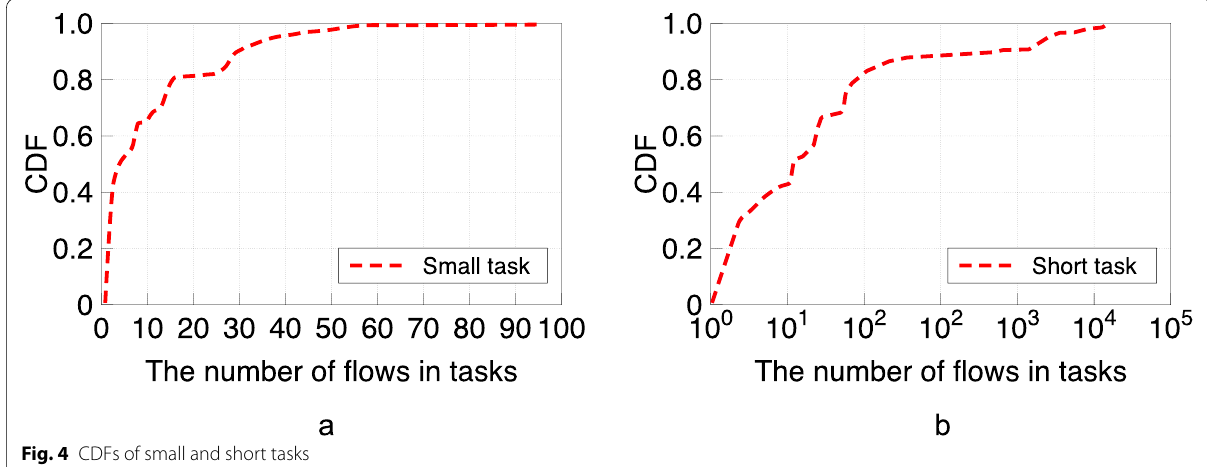
Fig. 4 CDFs of small and short tasks